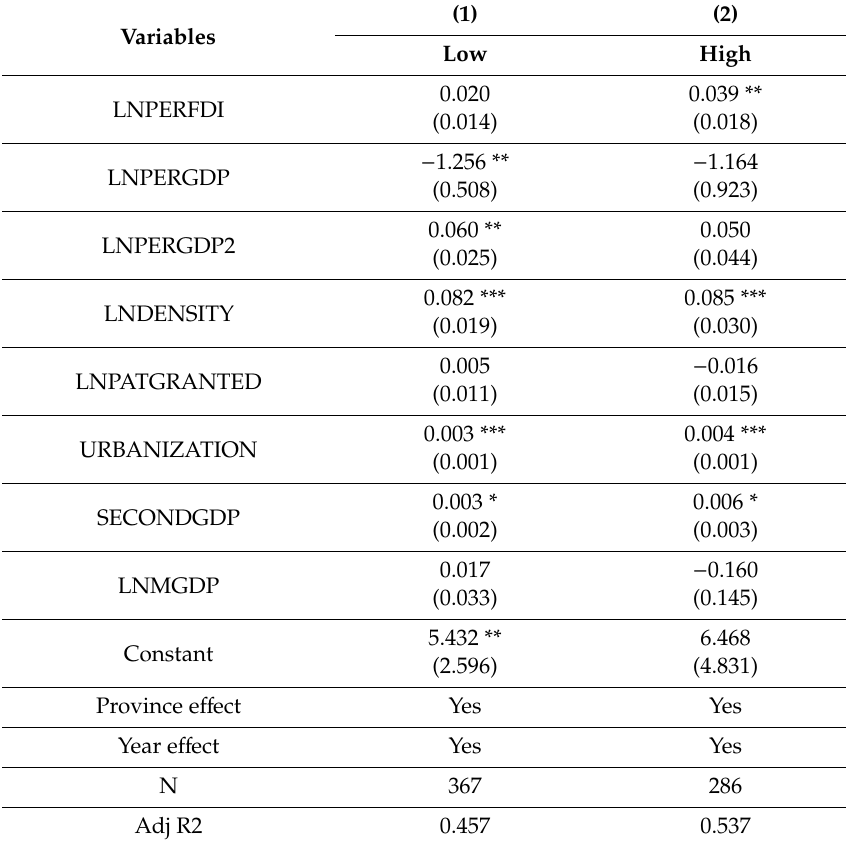
Table 5. Estimated results for the low and high fiscal pressure